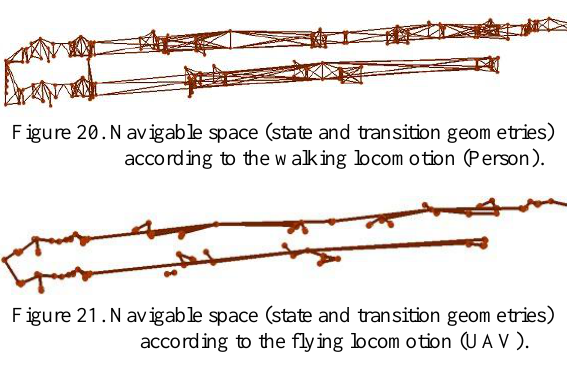
Figure 19. Navigable space (state and transition geometries) according to the driving locomotion (Wheelchair) in IndoorML.